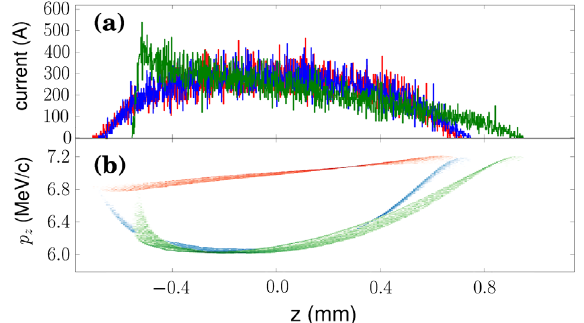
FIG. 13. Longitudinal wakefield (blue trace) produced behind a bunch with the longitudinal distribution (green trace) identical to the one shown in Fig. 12 [plot (a), green trace] for a bunch charge of 1 nC. The structure used for the wakefield generation has the geometric parameters a ¼ 165 μ m, b ¼ 197 μ m and ε r ¼ 5 . 7